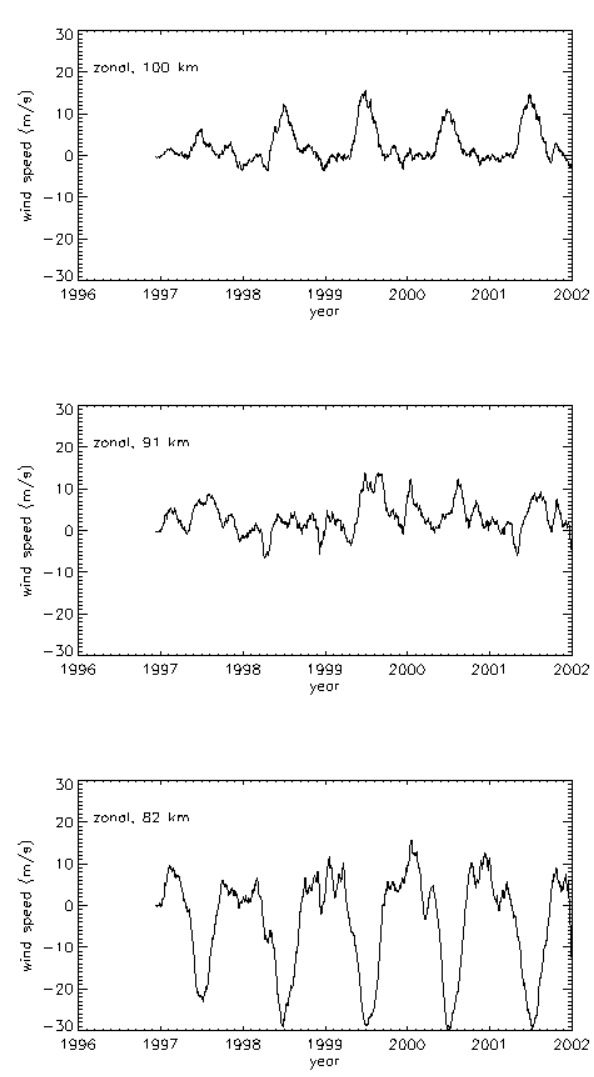
Fig. 7. As for Fig. 2, but for the zonal wind. bars) for the peak values and by rectangles for the frequency band means. The widths of these symbols indicate the band- widths, and their vertical extents show the accuracy